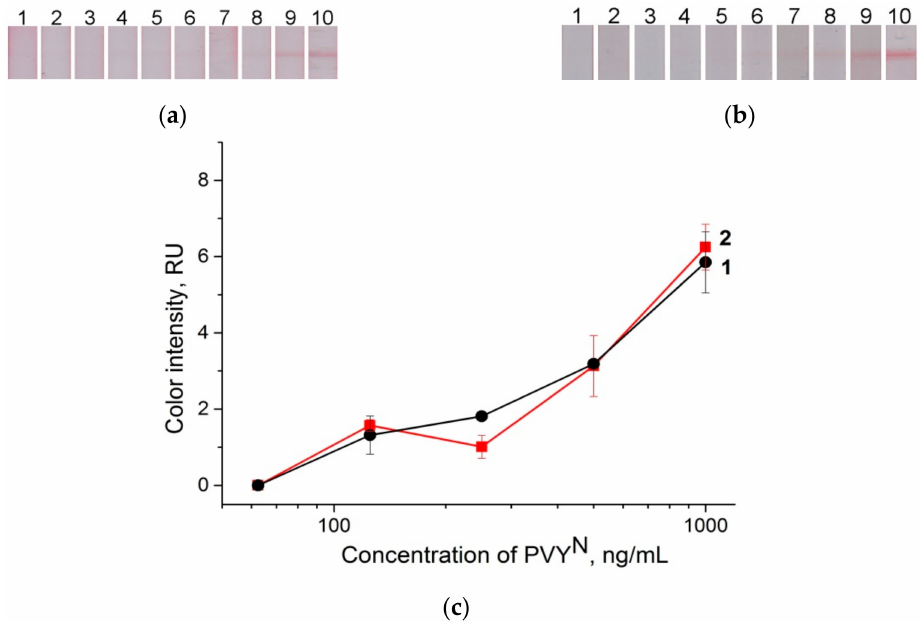
Figure 8. Lateral flow strips after testing of the samples containing PVY N with different LFIA schemes. ( a ) Test strips with longer (1-cm) conjugate pads and without sample membrane, ( b ) LFIA with sequential addition of virus and GNP conjugate; test strip 1 is the negative control (0 ng · mL − 1 ), test strips 2–10, PVY N concentration: 0.15 ng · mL − 1 , 0.46 ng · mL − 1 , 1 ng · mL − 1 , 4 ng · mL − 1 , 12 ng · mL − 1 , intensity of the test zone on the virus concentration, where curve 1 corresponds to the test strips in Figure 8a, and curve 2 corresponds to the test strips in Figure